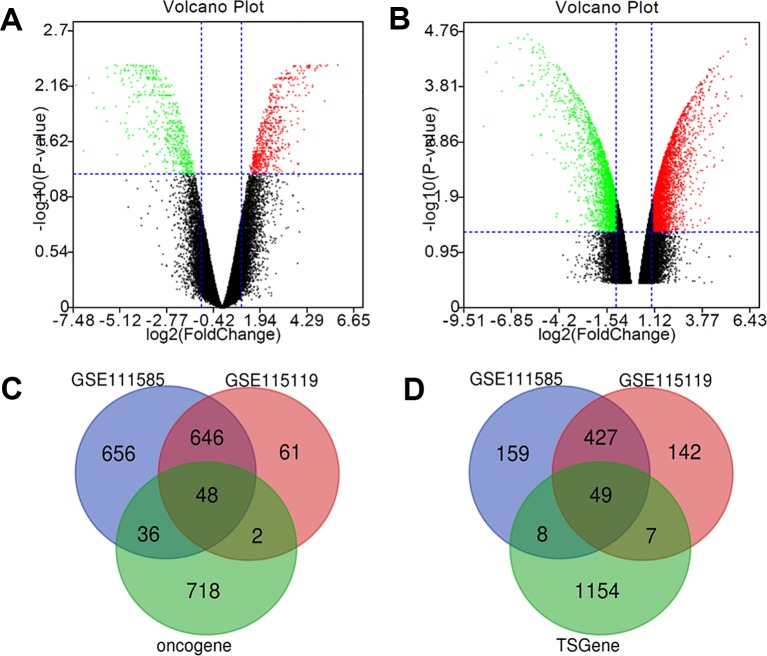
Identification of cisplatin-resistant DEGs in OSCC. (A) Volcano map of GSE111585. (B) Volcano map of GSE115119. (C) 48 up-regulated DEGs was selected based on the intersection between up-regulated gene in GSE111585/GSE115119 and oncogenes. (D) Forty-nine down-regulated DEGs was selected based on the intersection between down-regulated gene in GSE111585/GSE115119 and tumor-suppressor genes.